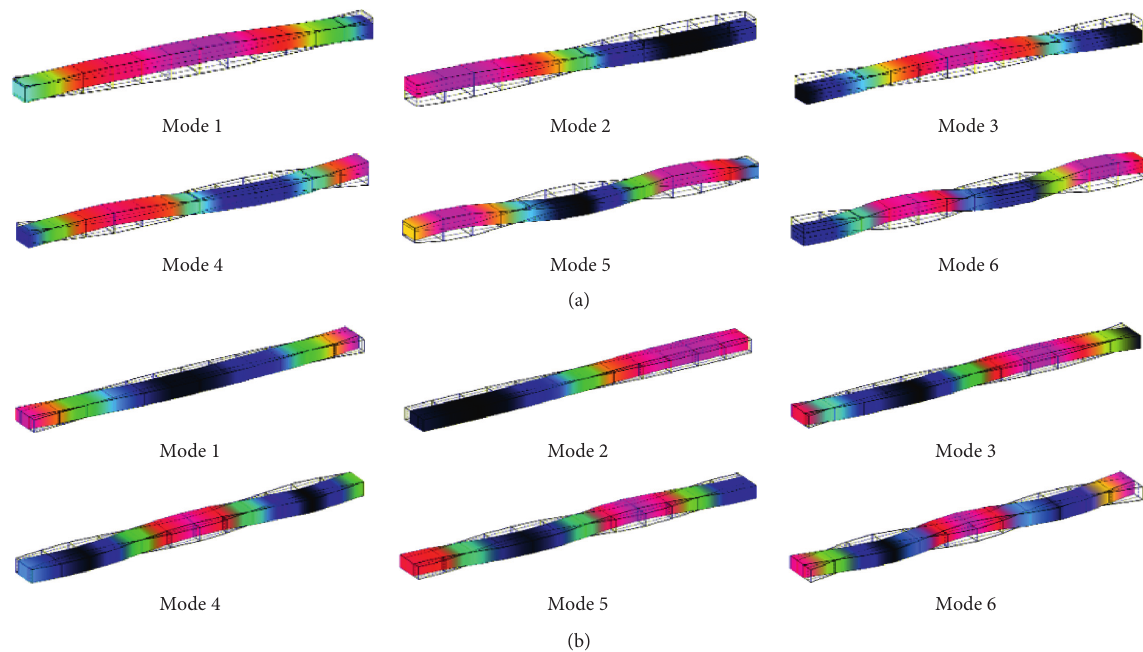
Figure 8: Test modal shapes of carbon strip: (a) vertical and (b) transverse.